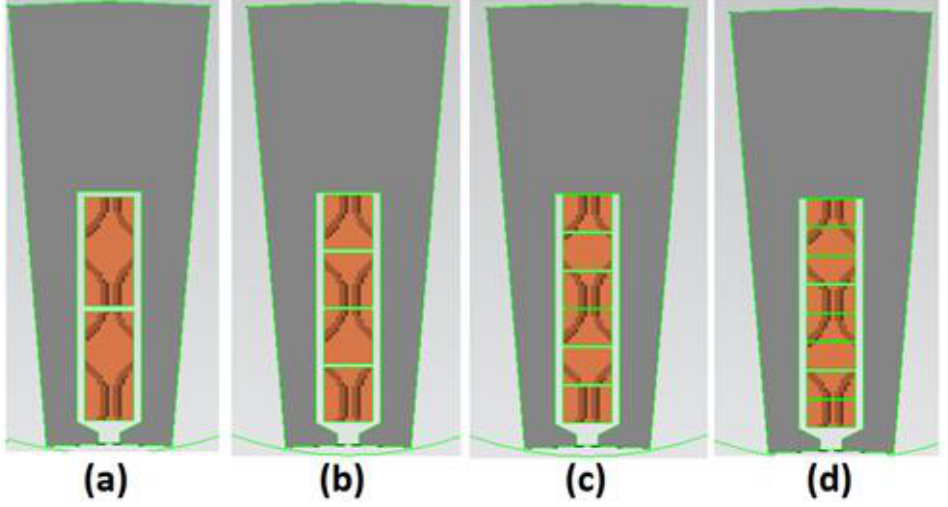
Figure 6. Various setups for considering the effect of conductor numbers on AC losses: ( a ) two-layer, ( b ) four-layer, ( c ) six-layer, and ( d ) eight-layer. Table 2. Dimension and current value of various configurations.